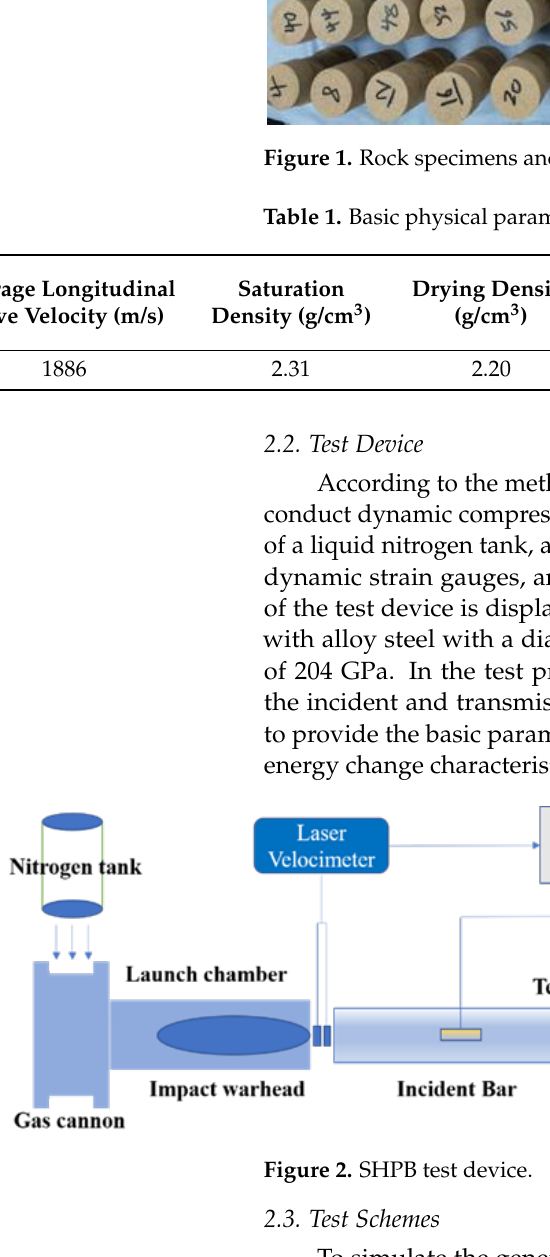
Figure 2. SHPB test device.